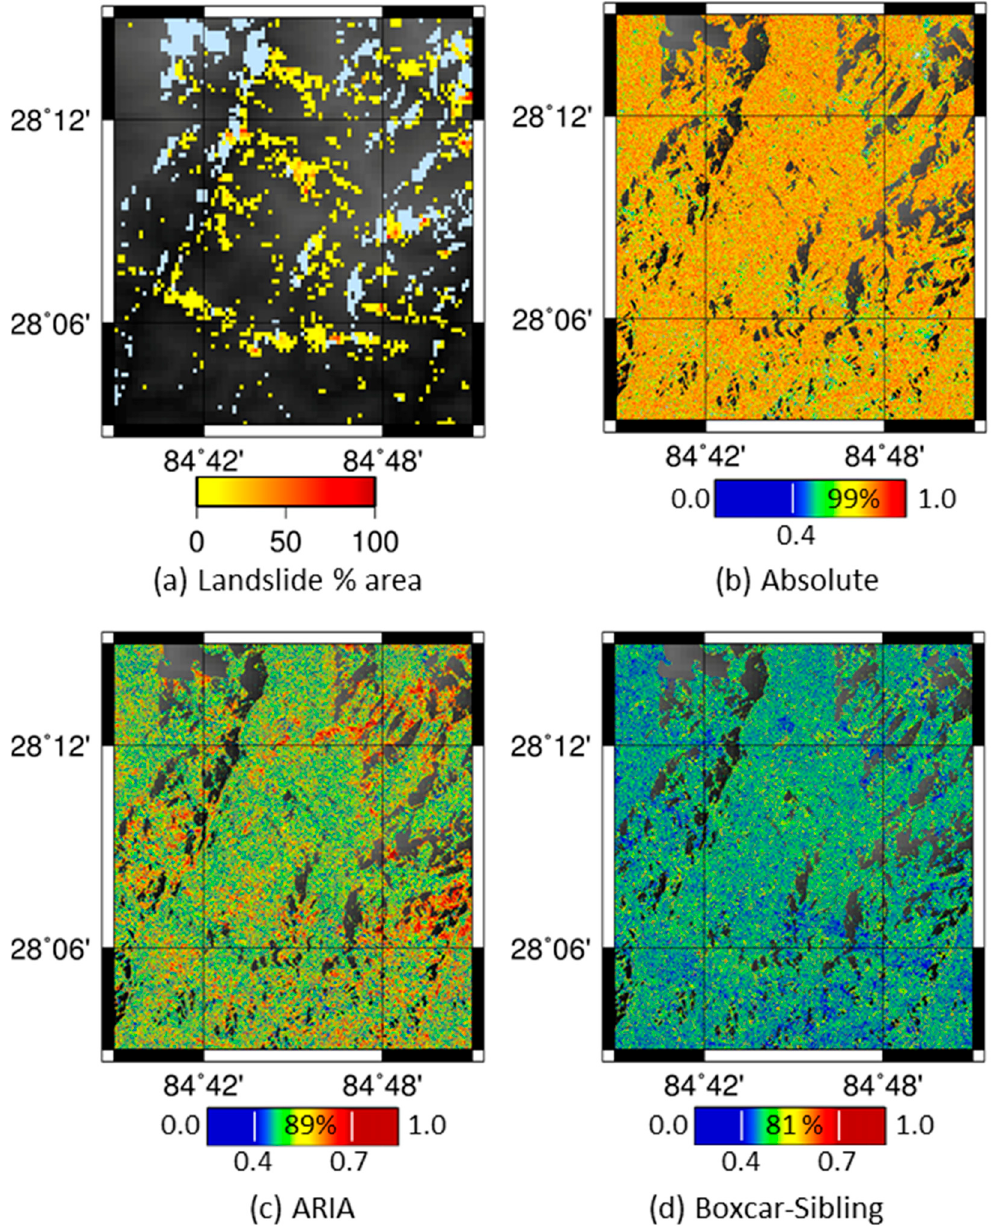
Figure A2. ( a ) The percentage of each 10 × 10 aggregate pixel made up of landslide pixels. ( b – d ) The classifier value before aggregation for the surfaces produced by absolute, ARIA and Bx-S methods respectively. Each surface has been normalised to range between 0 and 1 with 1 most likely to be a landslide. Colour bars are non-linear, but linear between the white lines and labelled with the percentage of pixels across the whole area that lie in this linear range. The area shown corresponds to the smaller area shown in Figure 10